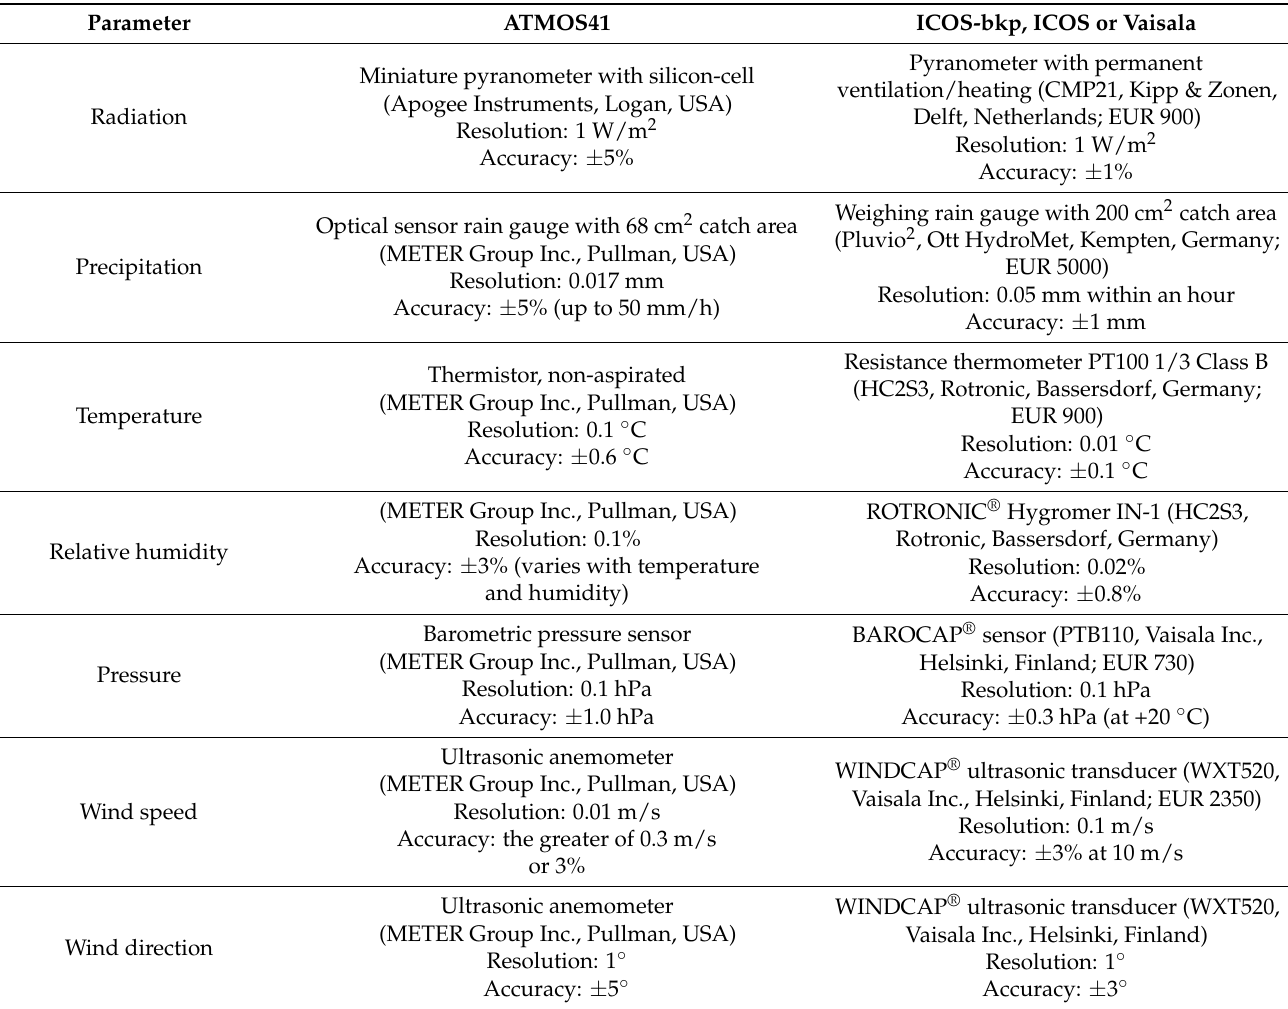
Table 2. Sensor details for the ATMOS41 weather station as well as the ICOS-bkp, Integrated Carbon Observation System (ICOS) or Vaisala